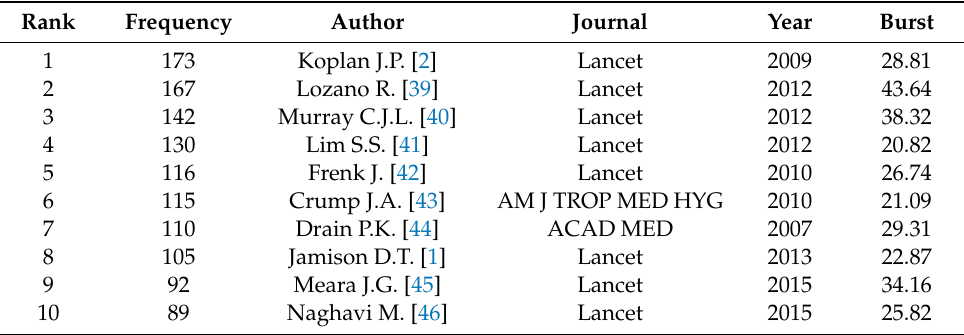
Table 6. Top 10 cited